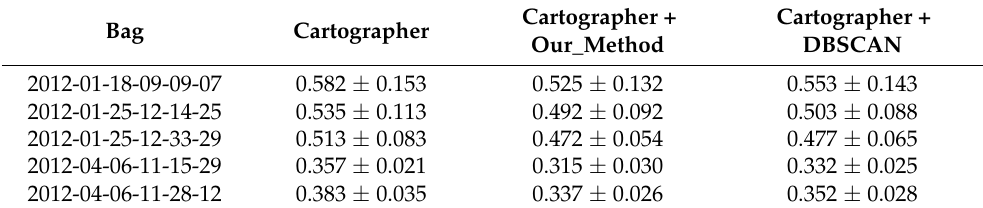
Table 2. Comparison of the impact of our method and DBSCAN method on RMSE (m). Bag